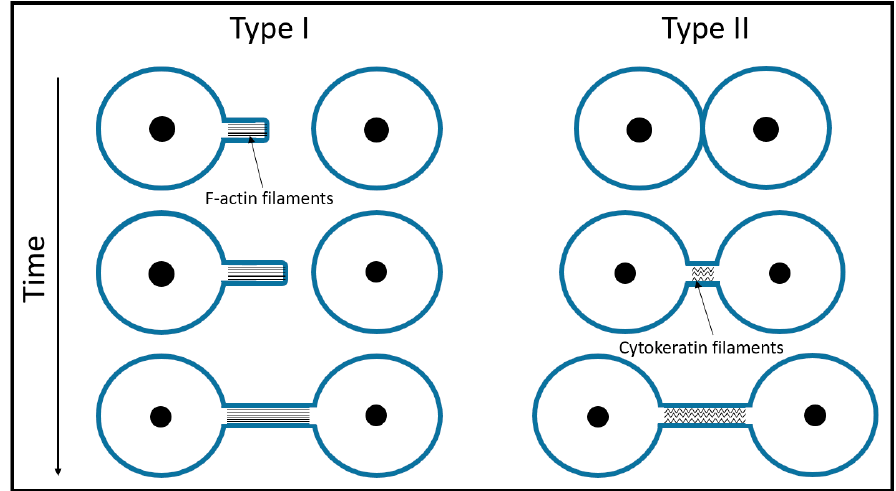
Figure 2. A schematic of TNT formation. Type I TNTs contain actin filaments and begin growing like filopodia. Usually, such protrusions appear in bunches of several tubes that dynamically seek connections with neighboring cells. Type II TNTs start growing as neighboring cells move apart. In the case of the urothelial lines RT4 and T24, some actin is still present at the entry point of the Type II tubes at the very beginning of the tube formation [11]. As the tube elongates, the actin gradually disappears and only cytokeratin filaments remain.